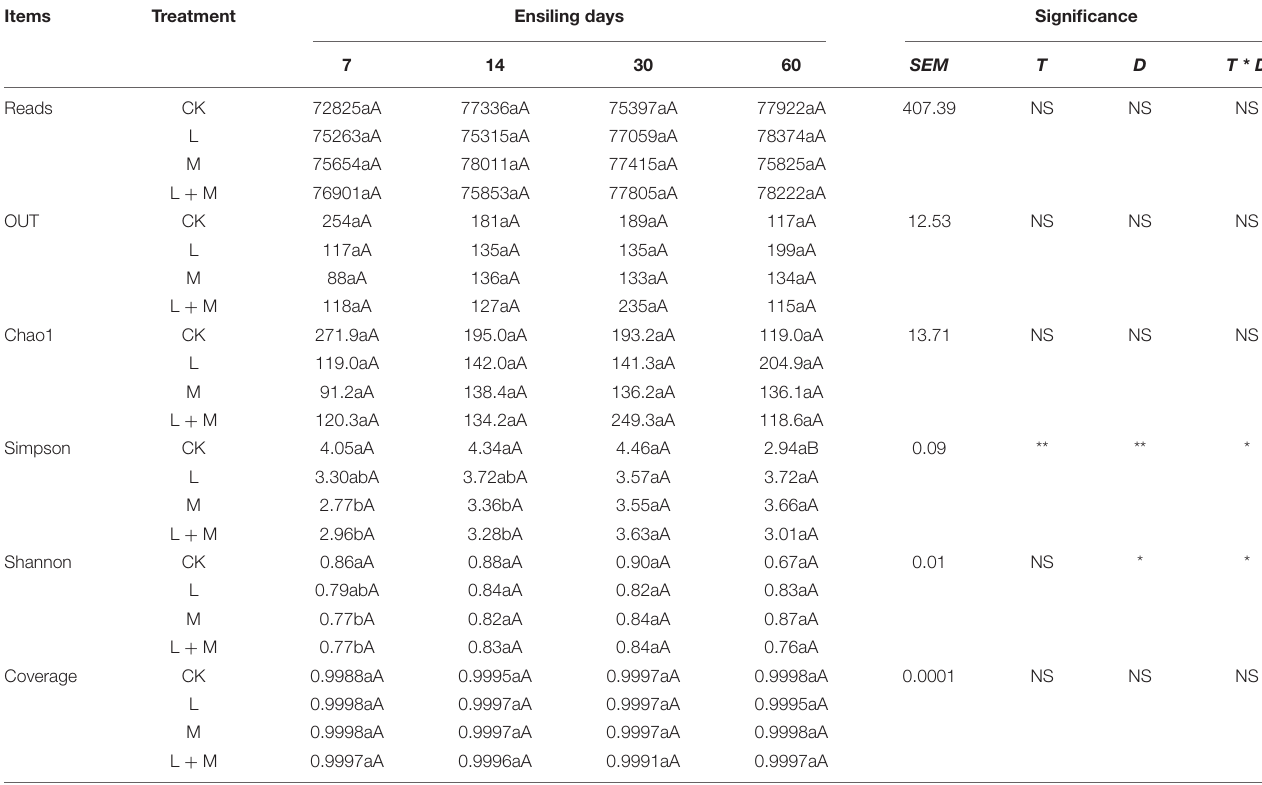
TABLE 5 | Effect of additives and ensiling days on bacterial alpha diversity of native grass silages. Items Treatment Ensiling days